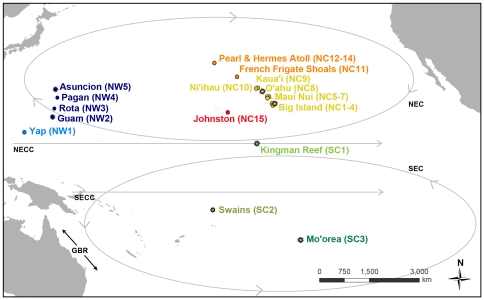
Sample locations of Acanthaster planci populations in the Pacific Ocean used in this study.Locations are color coded by region and shaded by subregion or archipelago. Shades of blue represent the northwestern Pacific (NW), shades of green represent the south central Pacific (SC), and red, orange, and yellow represent the north central Pacific (NC). The influential current paths in the central Pacific are represented: North Equatorial Countercurrent (NECC), North Equatorial Current (NEC), South Equatorial Countercurrent (SECC), and South Equatorial Current (SEC). GBR represents the Great Barrier Reef. Assigned location numbers that correspond to each region are represented in parentheses next to each site name and outbreak population locations are starred.